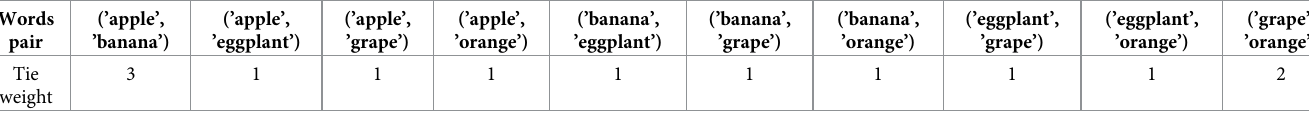
Table 3. Weight values of the ties between two words of “apple,” “banana,” “eggplant,” “grape,” and “orange” in